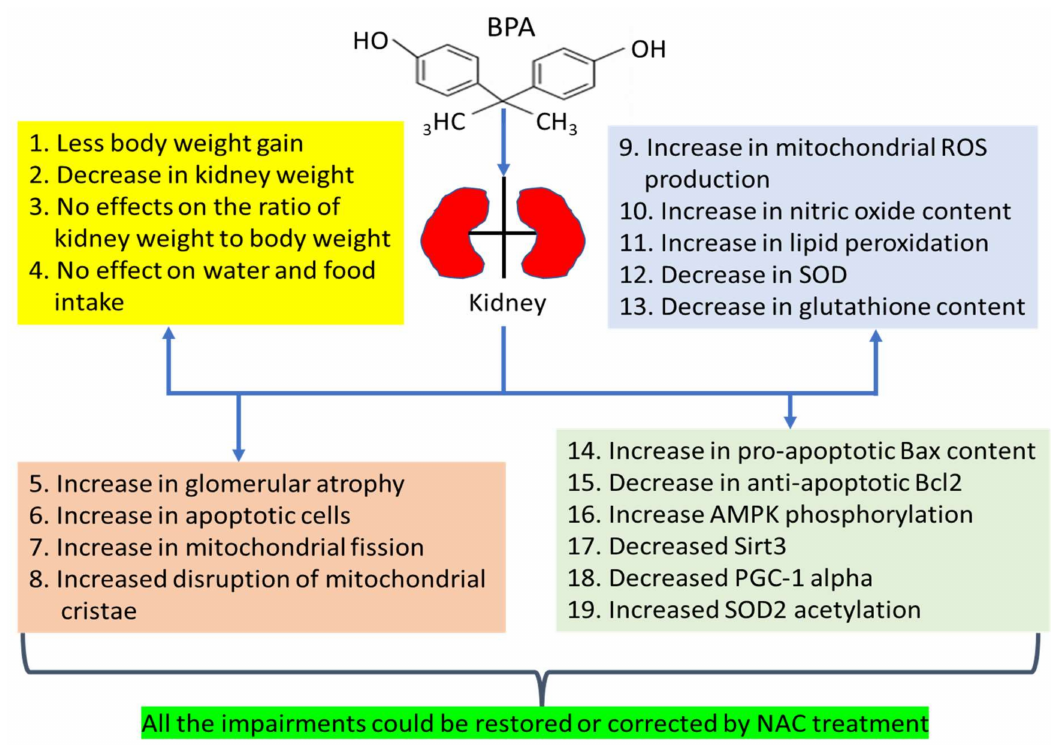
Figure 2. Various detrimental effects of BPA on the kidney and kidney mitochondria. All the impairments could be restored or corrected by 4 weeks of NAC treatment. ROS, reactive oxygen species; SOD, superoxide